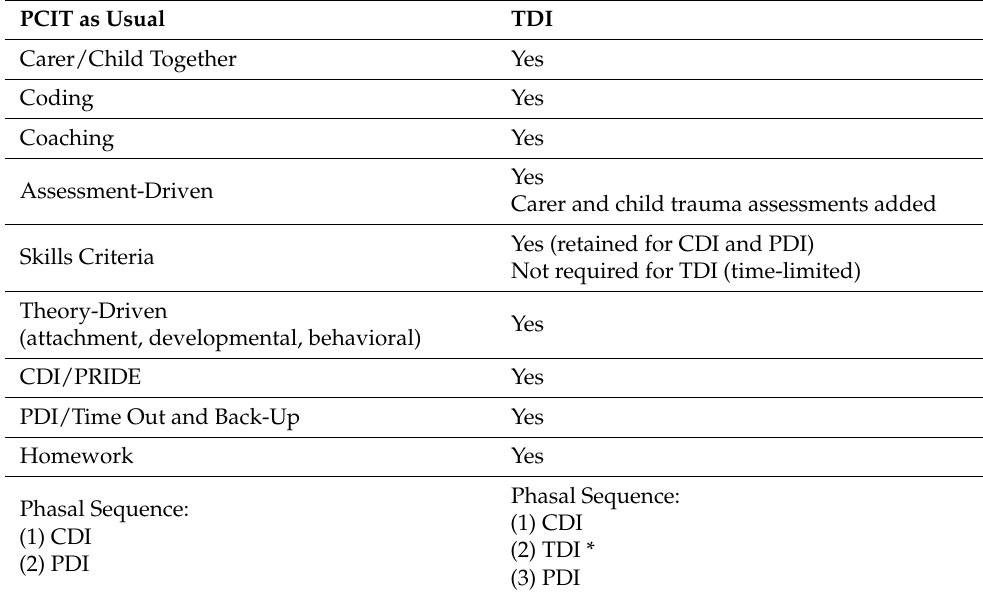
Table 1. PCIT as usual component comparison to